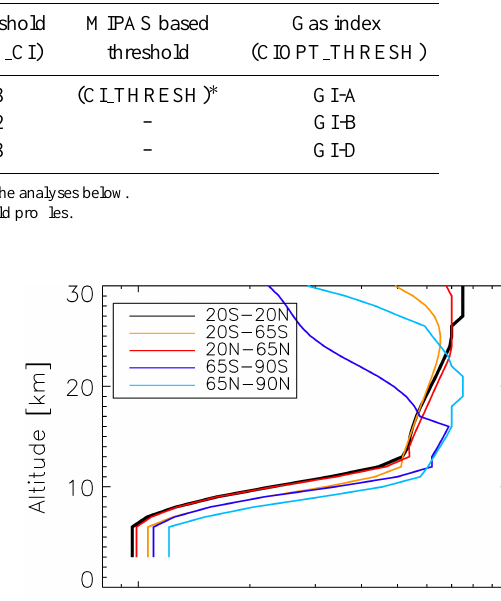
Table 1. Cloud index microwindows (MW) and thresholds/acronyms.